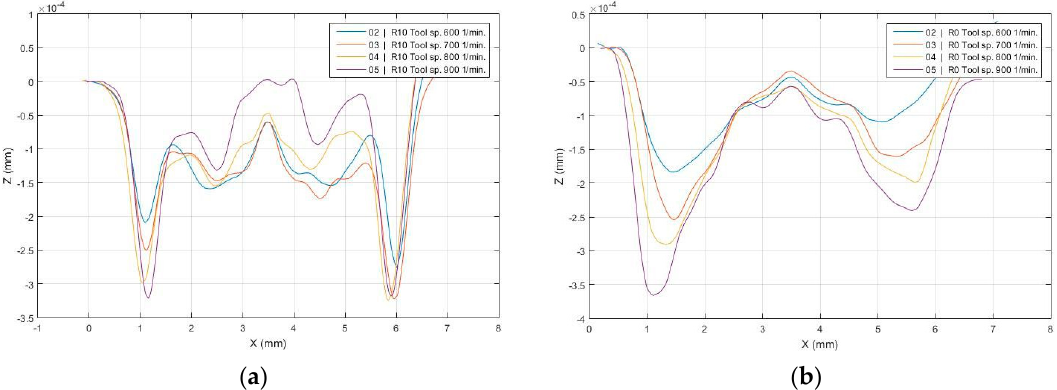
Figure 5. VEH R10 ( a ) and R0 ( b ) tools.